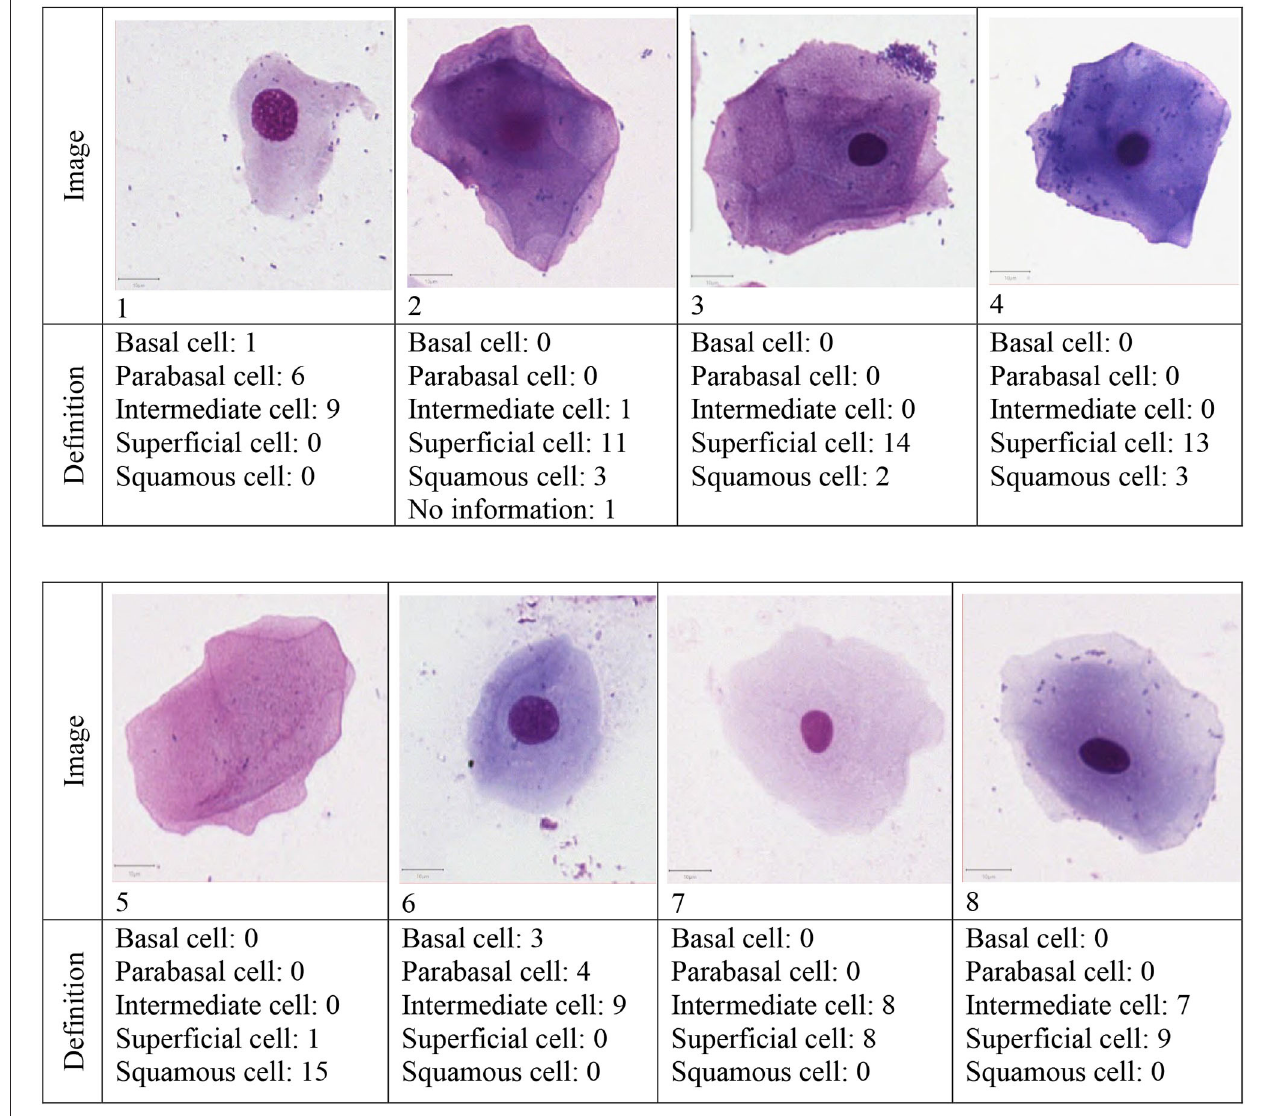
FIGURE 2 | Results of the determination of eight canine vaginal cells by 16